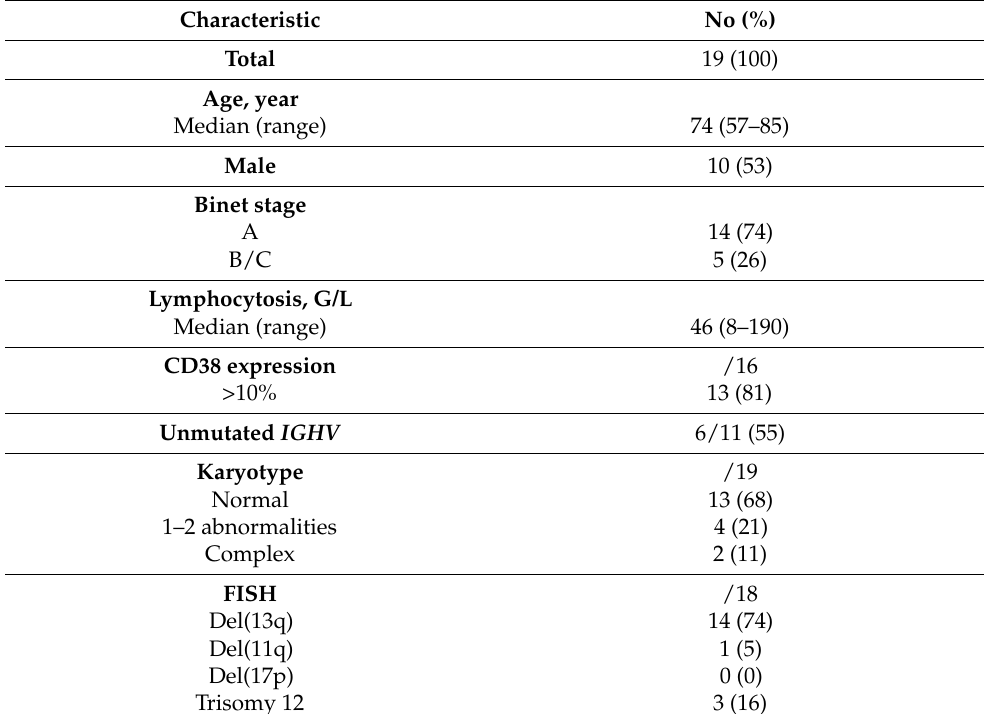
Table 1. Clinical characteristics of chronic lymphocytic leukemia (CLL)